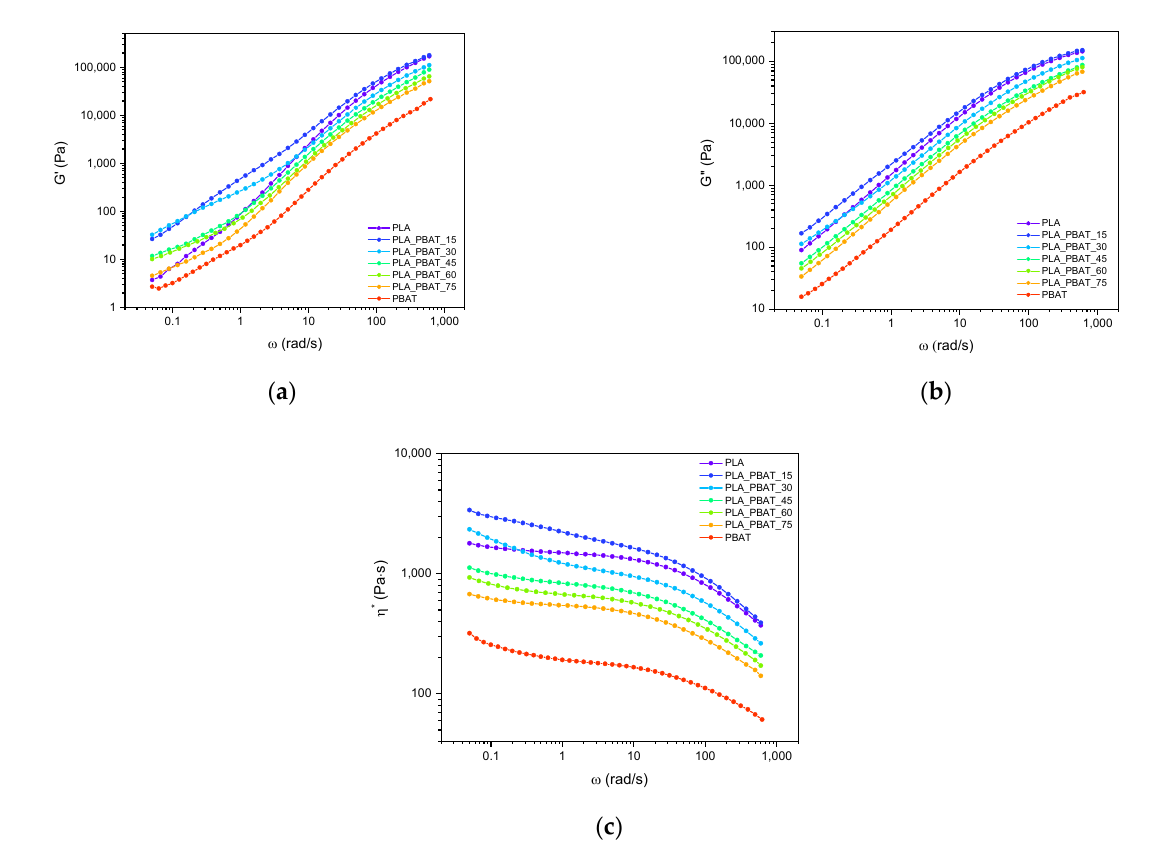
Figure 2. Results of the dynamic rheological tests at 180 °C on the neat matrices and on the prepared blends. Trends of ( a ) storage modulus; ( b ) loss modulus; and ( c ) complex viscosity as a function of the angular frequency.